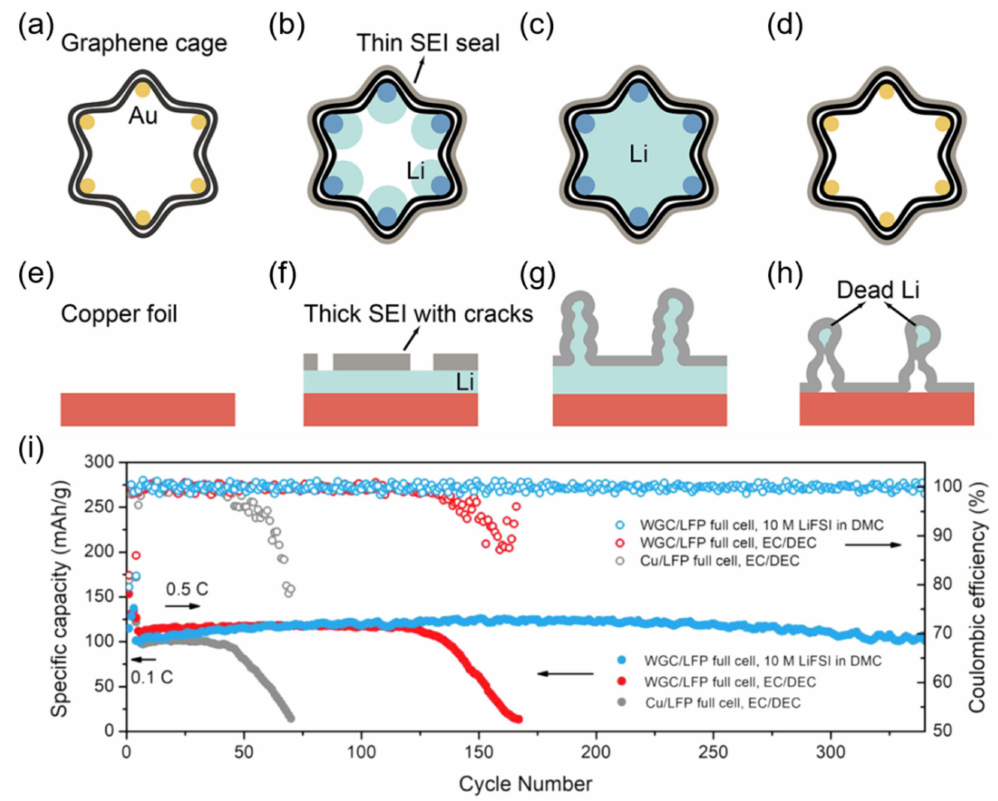
Figure 9. Comparison between the graphene cage and copper foil during Li deposition and stripping. ( a ) Pristine graphene cage. ( b , c ) The graphene cage after various amounts of Li deposition. ( d ) The graphene cage after Li stripping. ( e ) Bare copper foil. ( f , g ) The copper foil after various amounts of Li deposition. ( h ) The copper foil after Li stripping. ( i ) Full cell performance comparison between the graphene cage/Li electrodes and bare copper foil with electrodeposited Li metal under different electrolyte systems. Reproduced with permission from ref. [97]. Copyright 2019, ACS